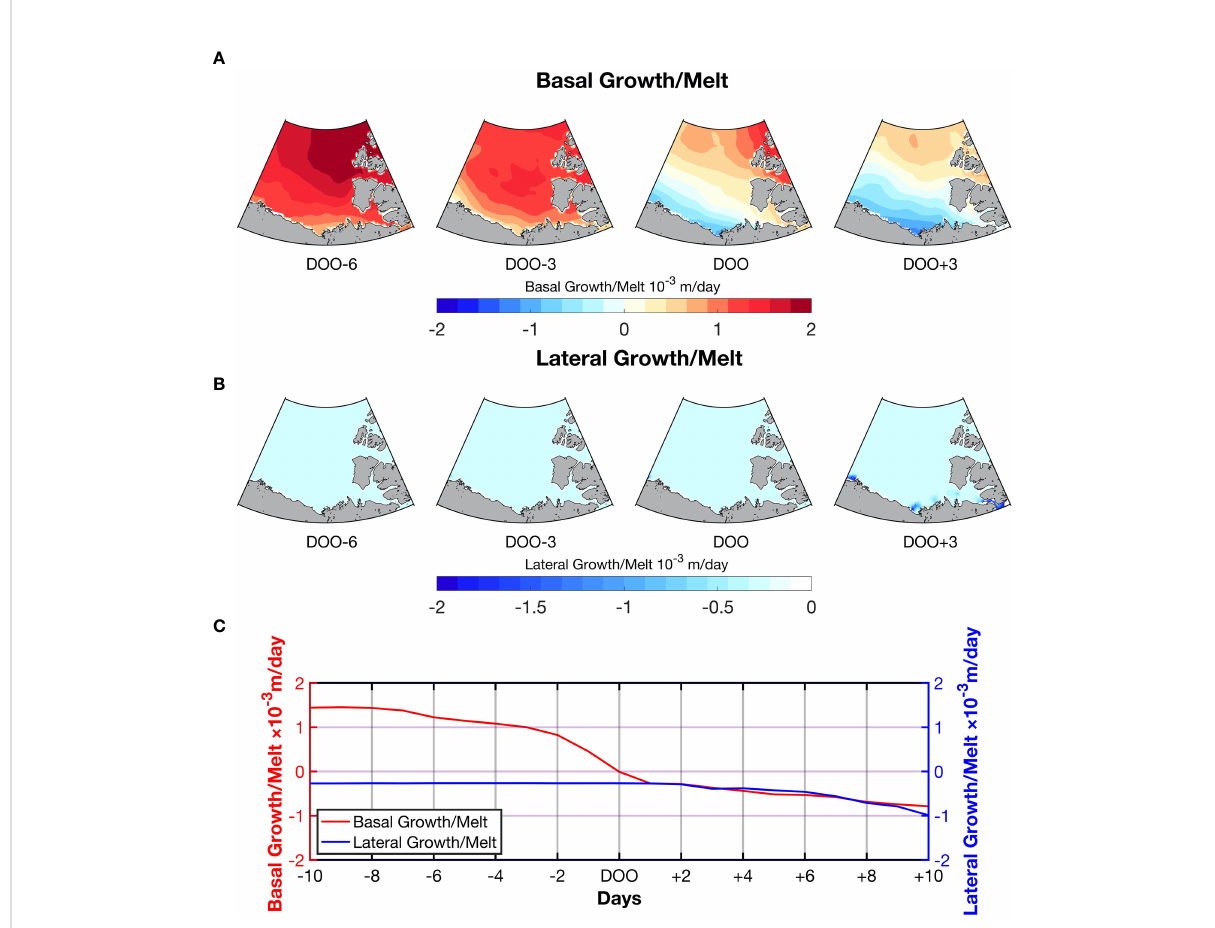
FIGURE 9 (A) Composite ice growth/melt rate at the bottom of the sea ice on DOO-6, DOO-3, DOO, and DOO+3. (B) Composite lateral melt rate on DOO-6, DOO-3, DOO, and DOO+3. (C) Composite time series of the ice growth/melt rates averaged over the region outlined in Figure 1A (the land area is masked out). A negative (positive) value indicates ice melting